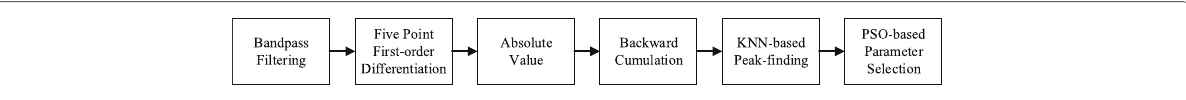
Fig. 2 The block diagram of the proposed R-peak detection